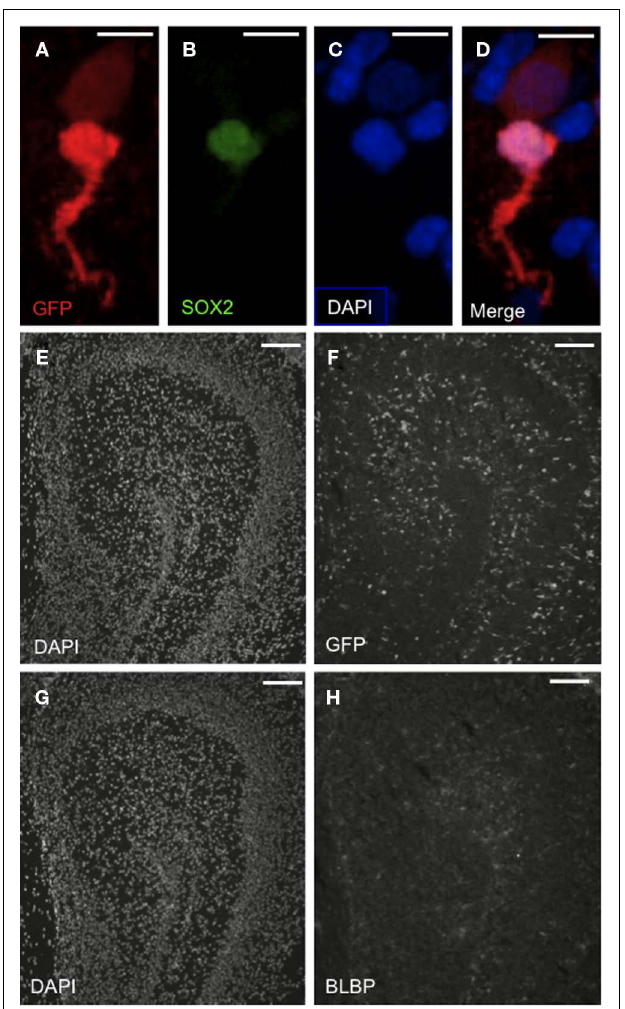
FIGURE 6 |The Egr-1-d2EGFP transgene is expressed in SOX2 + cells in postnatal rat brain. Representative fluorescence microscopic images of P2 rat brain showing immunohistochemically detected GFP + cells in the context of cellular proteins and DAPI + cells (blue/white). (A–D) Representative cells in insular cortex. Note that GFP is expressed in two cellular populations: SOX2 + (“bright” GFP) and SOX2 − (“dim” GFP). Scale bars = 10 μ m. (E–H) Distribution of GFP + cells in the hippocampal field relative to DAPI and BLBP. Note the widespread, ordered distribution of GFP + cells relative to the sparse distribution of BLBP + cells. Scale bars = 100 μ m.